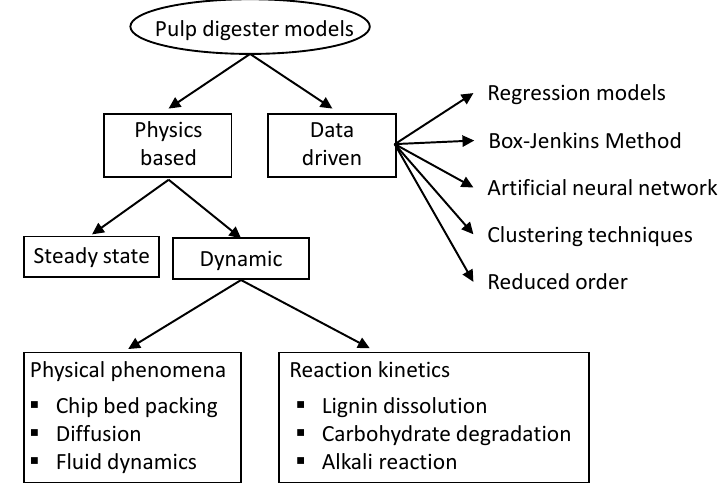
Figure 7. Overview of pulp digester